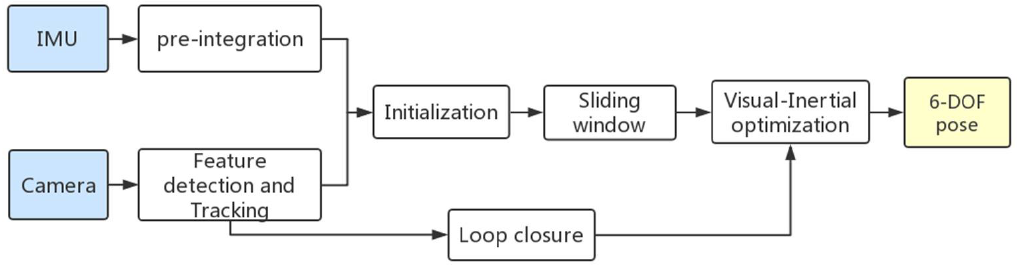
Figure 1. A block diagram illustrating our Visual-Inertial optimization framework.